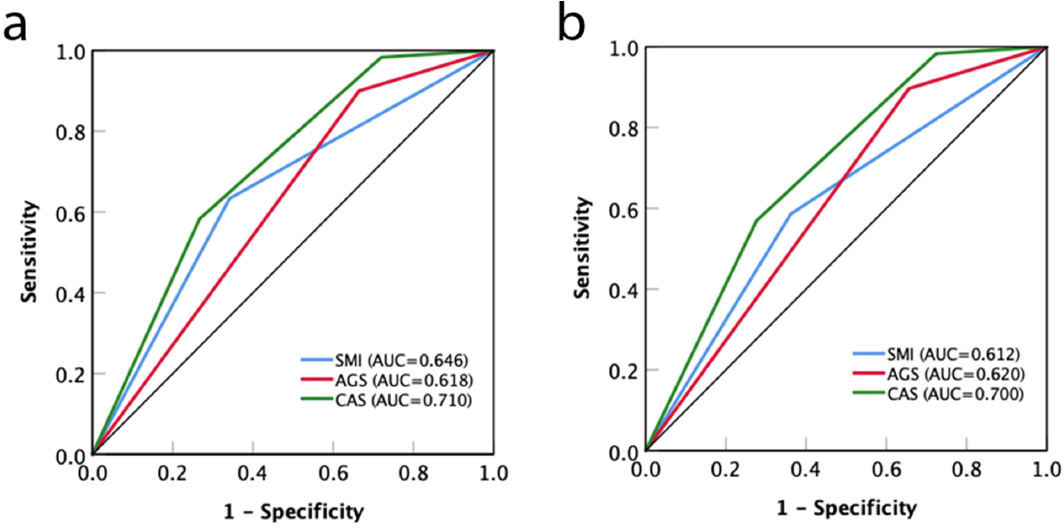
Figure 5. Comparison of AUC for AGS, SMI, and CAS grade in predicting overall survival ( a ) and recurrence-free survival ( b ) in the study cohort. AUC, area under curve; AGS, albumin–globulin score; SMI, skeletal muscle index; CAS, combination of albumin–globulin score and skeletal muscle index.